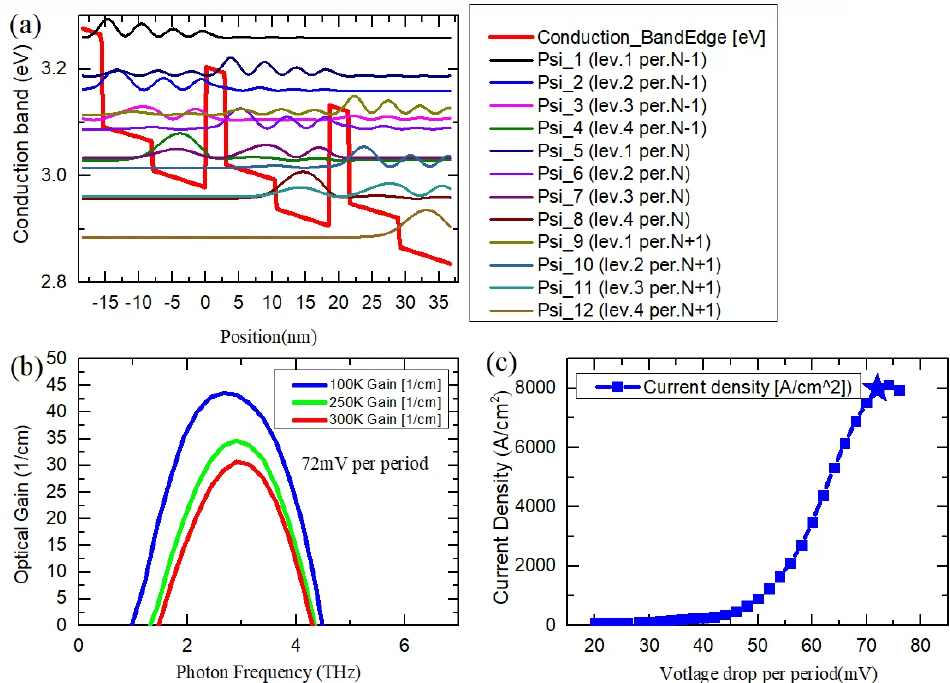
Figure 2. Q1W-B (3.0 nm Al 0 . 27 Ga 0 . 73 As/7.5 nm Al 0 . 07 Ga 0 . 93 As/8 nm GaAs) simulation result by NEGF model. ( a ) Conduction band diagram. ( b ) Calculated temperature-dependent optical gain. ( c ) Voltage–current density curve at 100 K. NEGF simulation is performed by using the nextnano. NEGF simulation tool from [35].